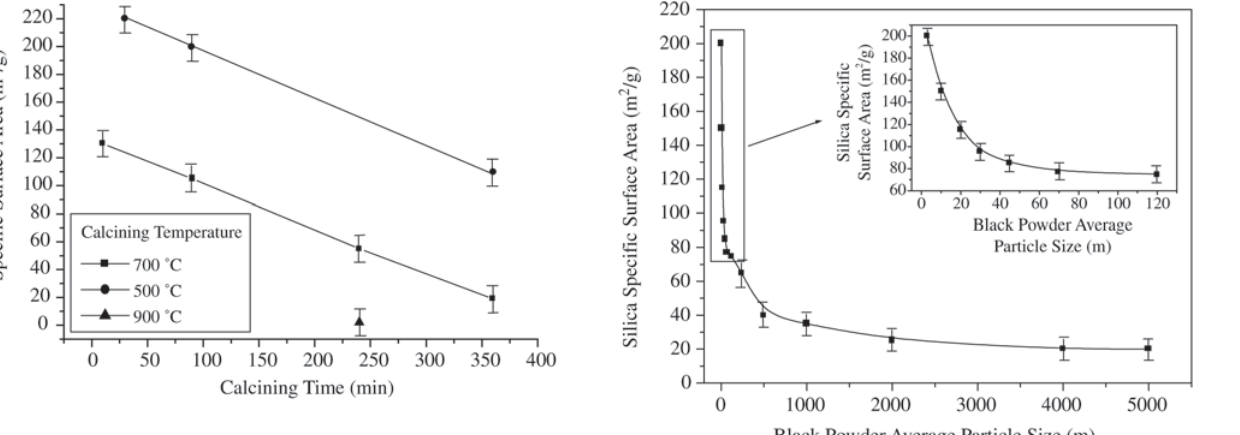
Figure 3 . Dependence of the specific surface area on calcining time and temperature for samples prepared by processes E. The triangle refers to process